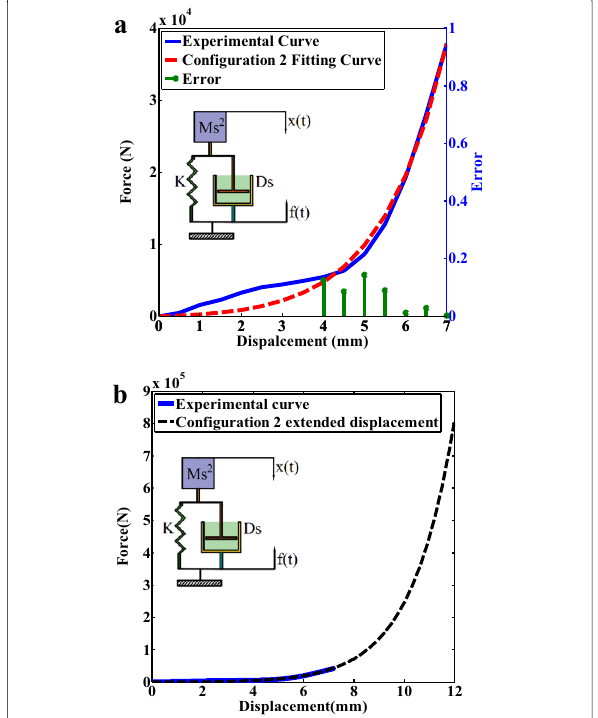
Figure 4 Configuration 2 equivalent mechanical model and verification results: a Results of experimental data and Eq. (12), b Verification of extended displacement of Eq. (12)